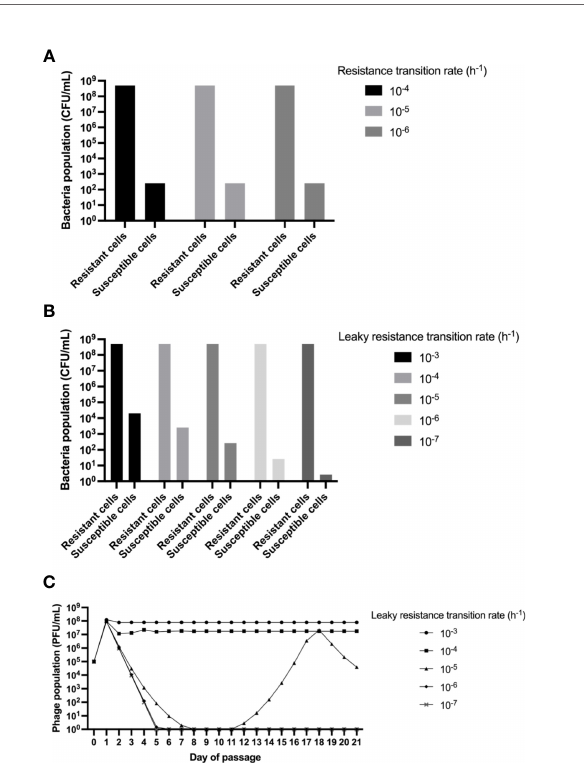
FIGURE 2 | Population density of S. Enteritidis and a lytic phage for 21 days. (A) Population density of S . Enteritidis for the 21 days of experimental coevolution. (B) Phage titer for the 21 days of experimental coevolution. For both, the control without the phage/bacteria are in black, and the four replicates are identi fi ed as replicate 1 (R1) in green, replicate 2 (R2) in orange, replicate 3 (R3) in red, and replicate 4 (R4) in blue. For both charts, day 0 corresponds to the time of the infection and day 1, 24 hours later.